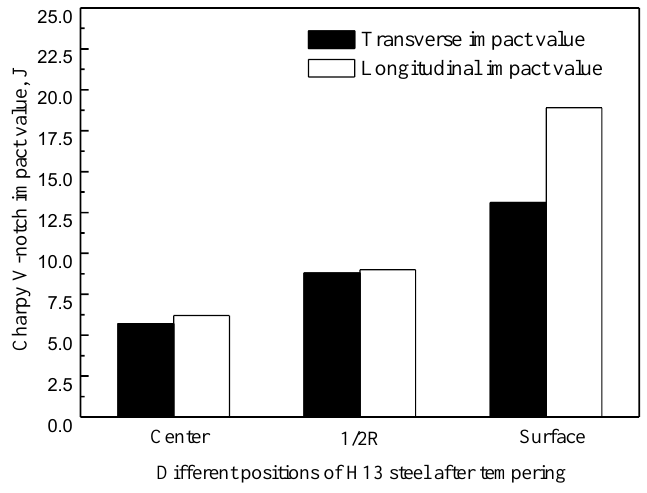
Figure 10. Impact values in different positions of H13 after tempering.